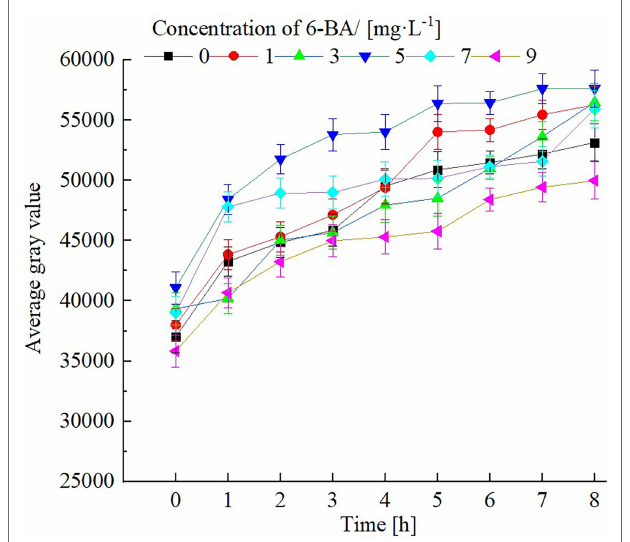
FIGURE 2 | Average gray value variation curve for a region of interest of soybean during soaking in 6-BA solution with different concentrations.